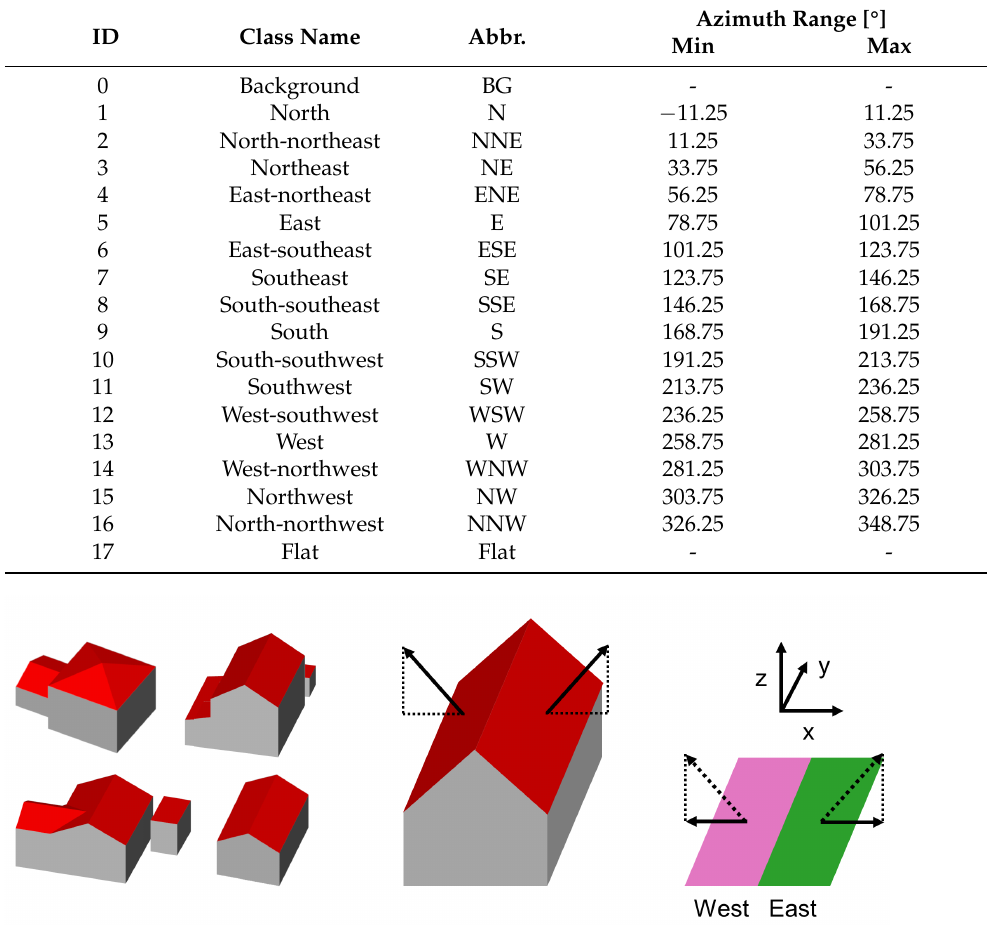
Figure 2. A graphical example of the approach to derive two-dimensional roof segment labels from 3D building models for the case of a simple gable roof. ( Left ): Exemplary 3D building models from the dataset. Center: The 3D representation of a building with the roof segments’ normal vectors. ( Right ): The resulting roof segment labels after projection onto the two-dimensional plane and assignation of an orientation class according to a chosen mapping from the continuous azimuth to discrete bins. The axes x and y refer to longitude and latitude,